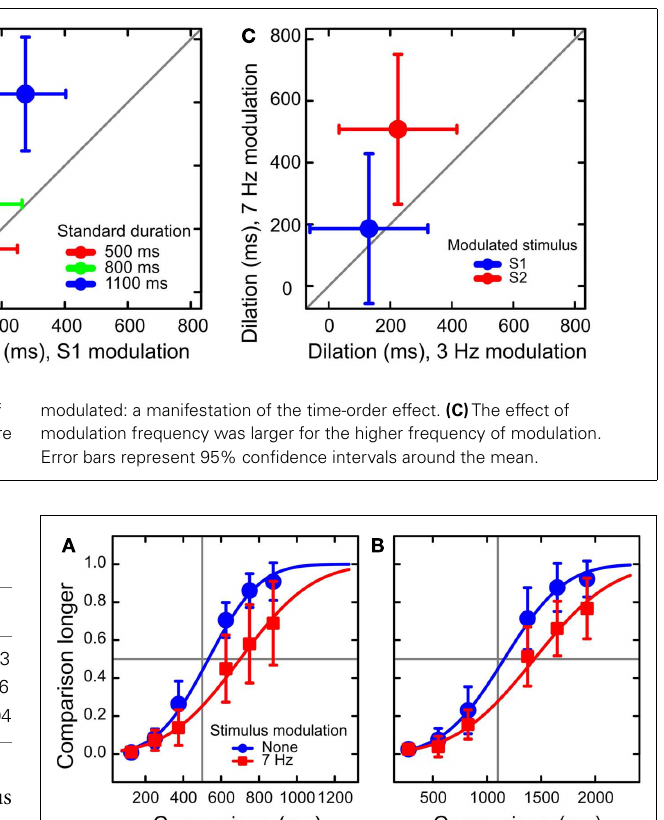
FIGURE 2 | Results of Experiment 2: psychometric functions. The data are plotted separately for standard durations of 500ms (A) and 1100ms (B) . The red squares and blue circles represent the conditions of luminance modulation present and absent, respectively.The data are averaged across observers.The curves are the cumulative normal fits to fractions of reports that the comparison stimuli appeared to be longer than the standard stimuli. The psychometric functions for 7Hz modulation are shifted to the right relative to those with modulation absent, which is a manifestation of time dilation. Error bars represent 95% confidence intervals around the